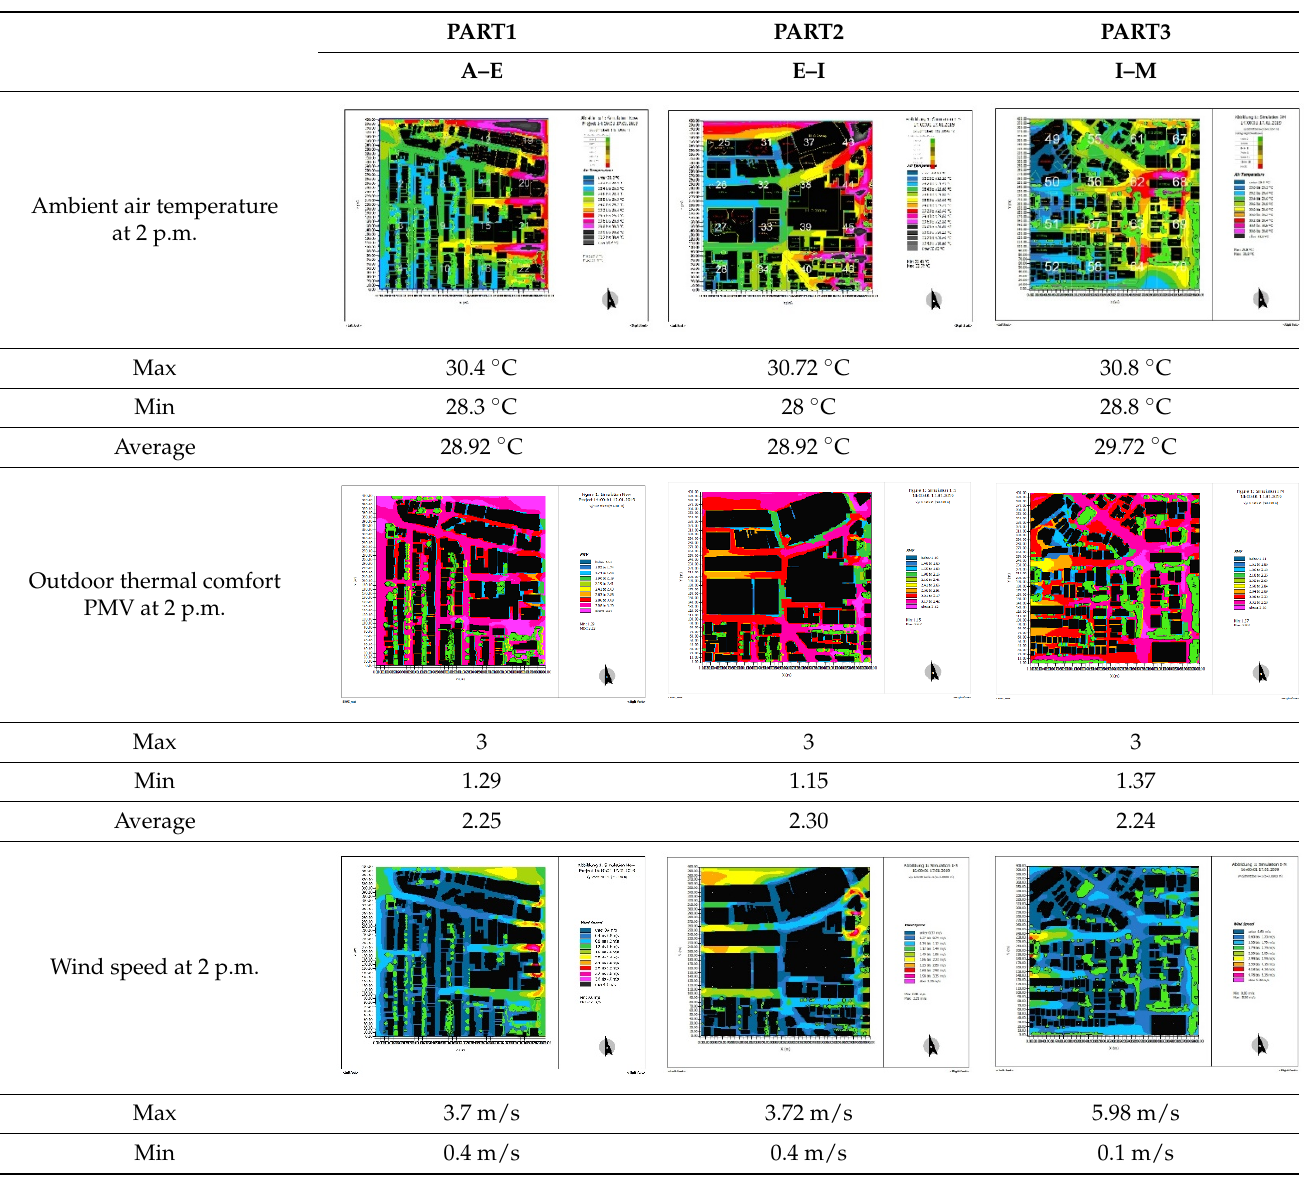
Table 8. Base case ambient air temperature, outdoor thermal comfort, and wind speed distribution maps in all parts at 2 pm.